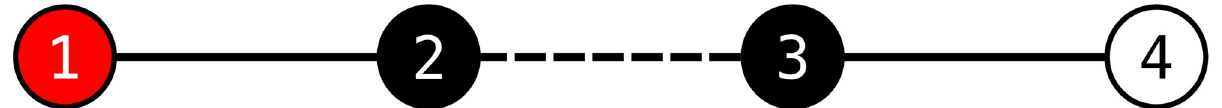
Fig 1. A simple multiplex network. The line style corresponds with the relationship type. The node color represents its current status: infected (red), susceptible (white), and unknown (black).